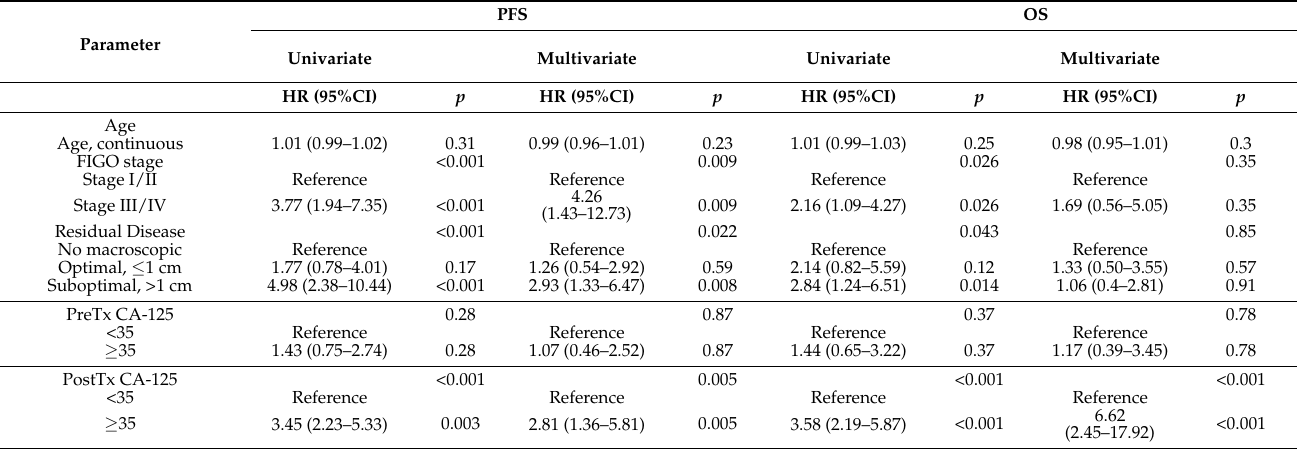
Table 2. Univariate and multivariate cox proportional hazard model for progression-free and over- all